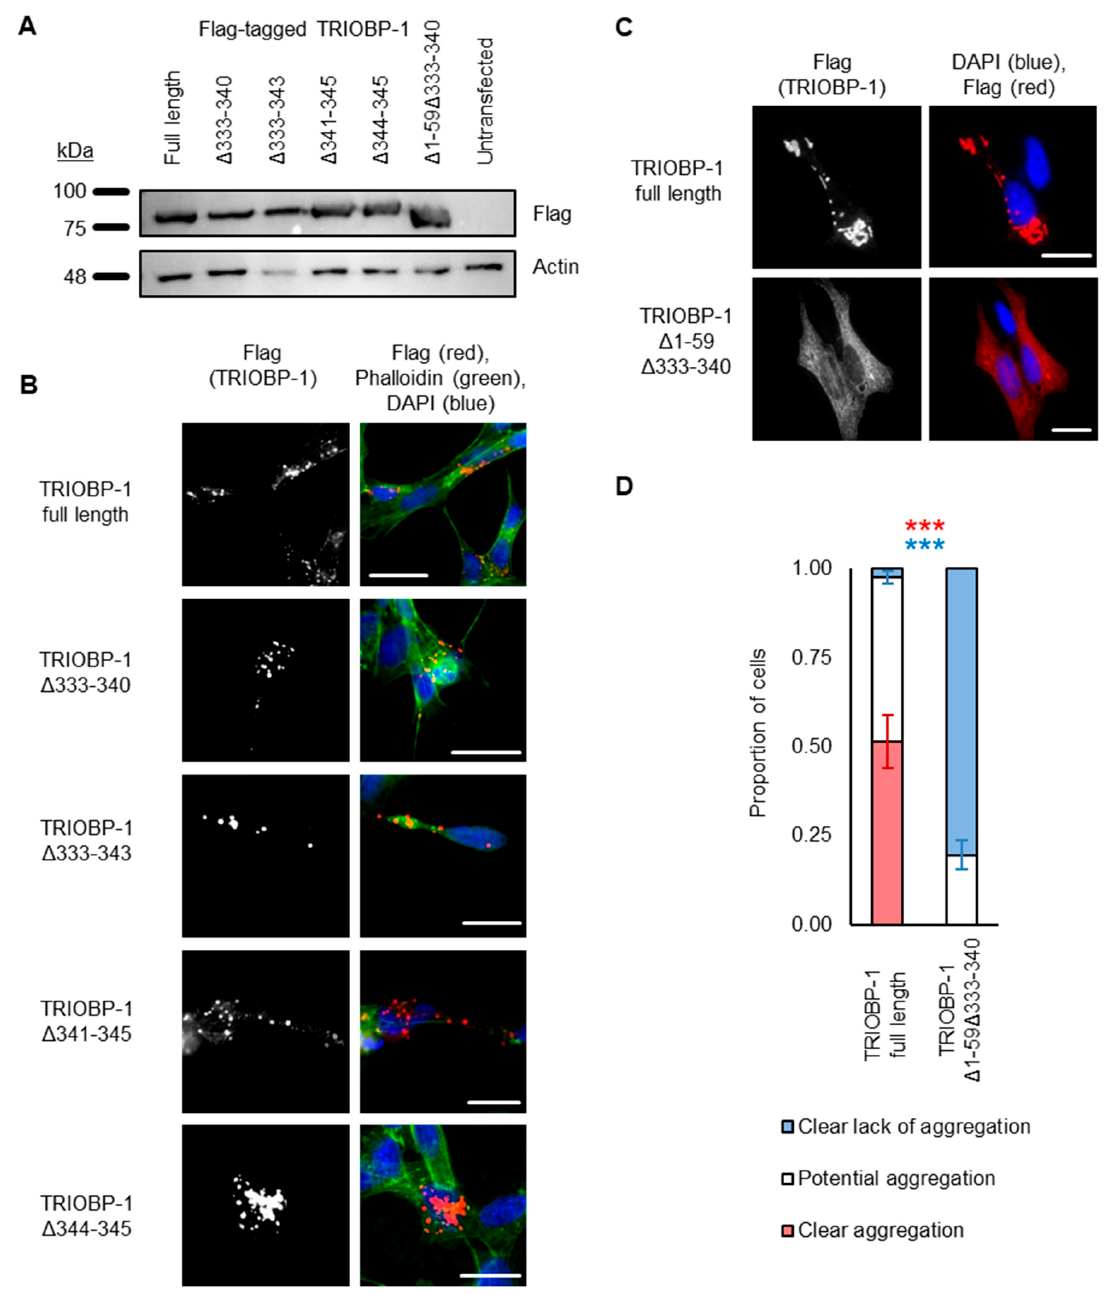
Figure 4. The central section of TRIOBP-1 is not the only aggregation-critical region. ( A ) Western blot of plasmids used in this figure, expressed in HEK293 cells. ( B ) Deletion of 2–11 amino acids deleted from the putative aggregation critical region in the center of the protein does not completely abolish aggregation. ( C ) Full-length TRIOBP-1 lacking the N-terminal 59 amino acid optionally translated domain and amino acids 333-340 shows almost no sign of aggregation, while the equivalent full-length protein does. ( D ) Confirmation of this difference in a blinded, quantified assay. Full length: n = 103 and Δ 1-59 Δ 333-340: n = 101. For both clear aggregation (red) and clear lack of aggregation (blue), *** indicates p < 0.001. All images show Flag-tagged proteins expressed in SH-SY5Y cells (except where noted) and images are typical of 3 independent experiments. The scale bars represent 10 μ m.